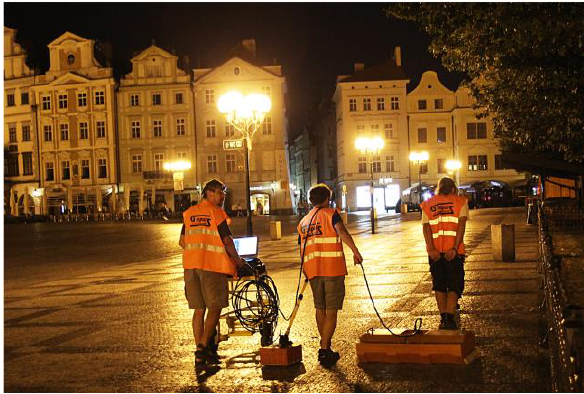
Figure 14. The GPR equipment with two antennas (see boxes on the pavement) in the work.